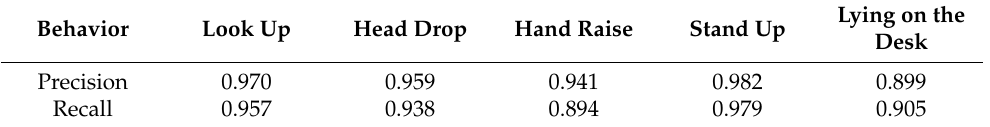
Table 3. Evaluation results on the student dataset.